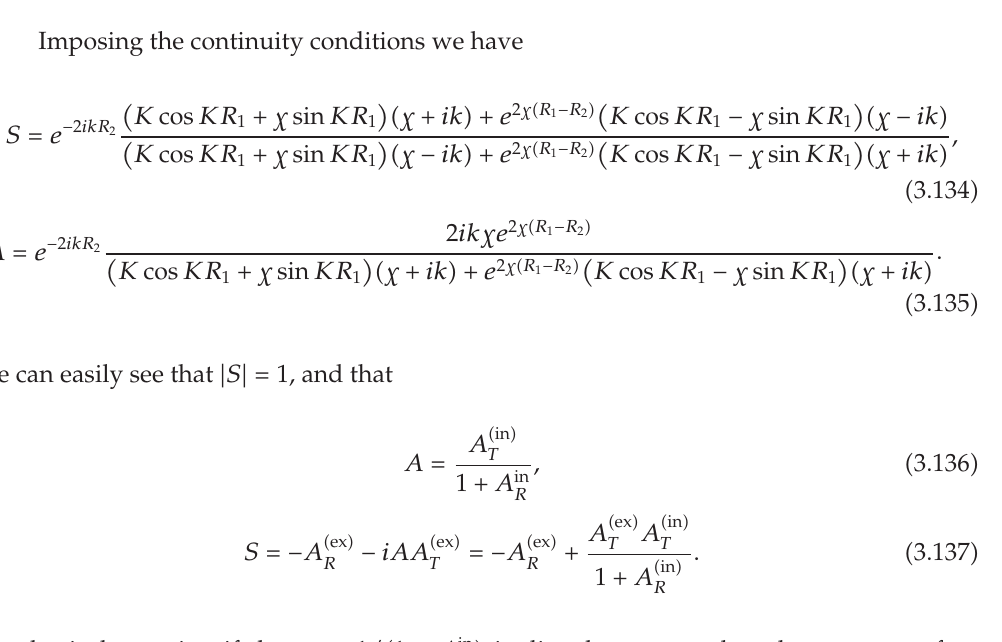
Figure 11: Schematic view of the whole scattering